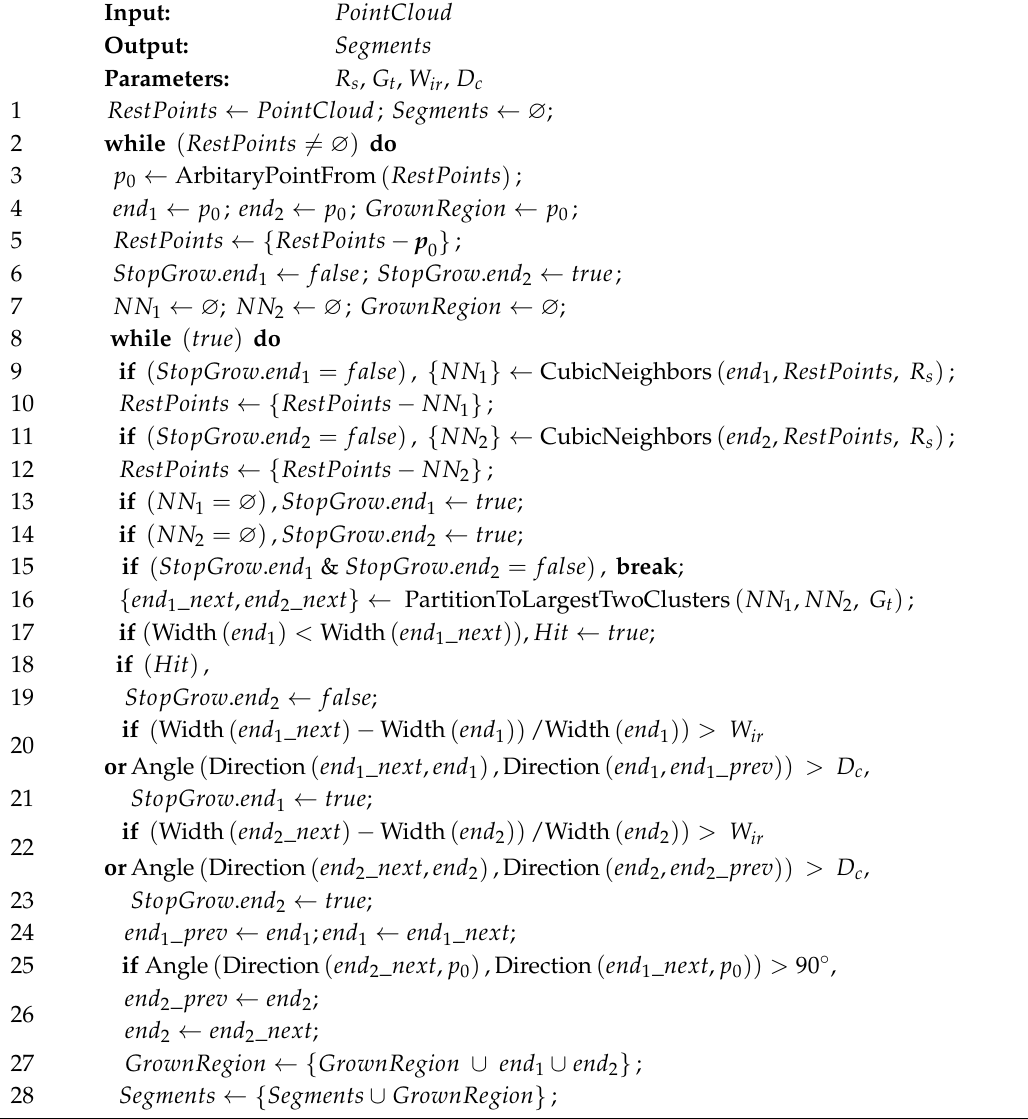
Algorithm 1. Description of point cloud segmentation using region growing